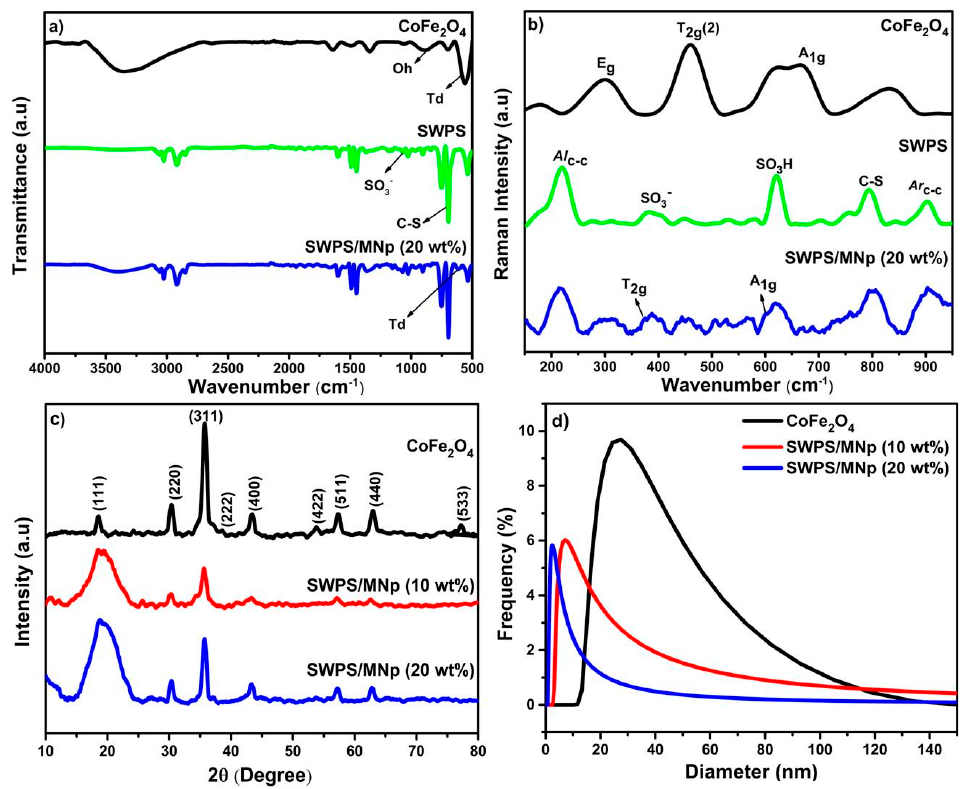
Figure 1. ( a ) ATR − FTIR spectrum; ( b ) Raman spectrum; ( c ) XRD patterns and ( d ) DLS measurements for size distributions.